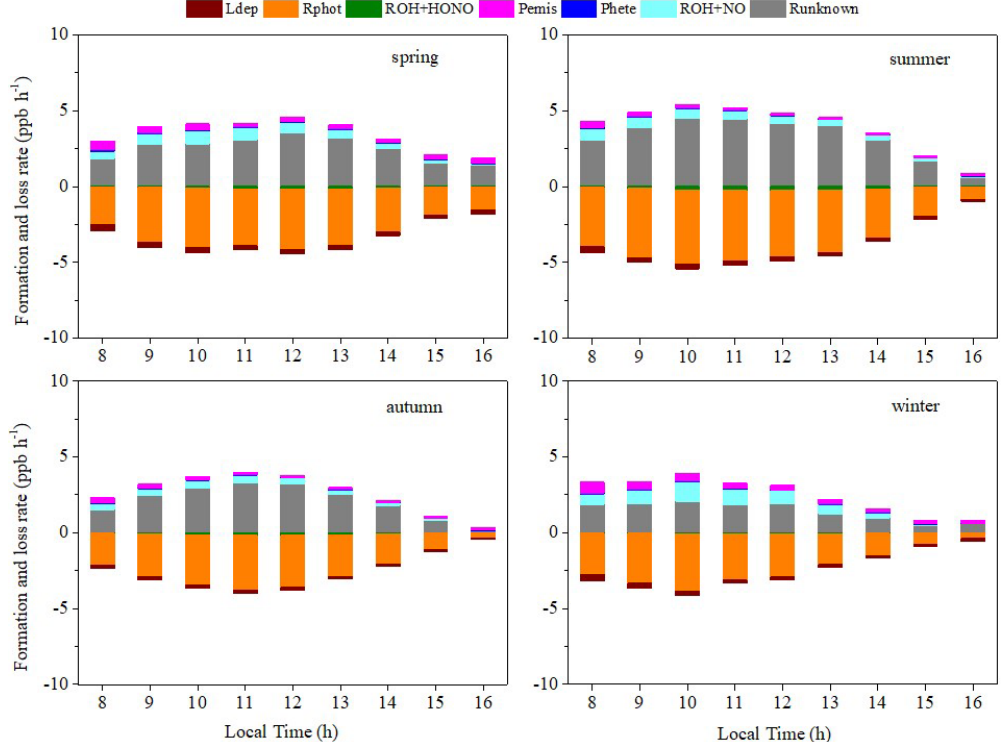
Figure 8. Average diurnal variations of each source ( > 0) and sink ( < 0) of HONO in the four seasons.